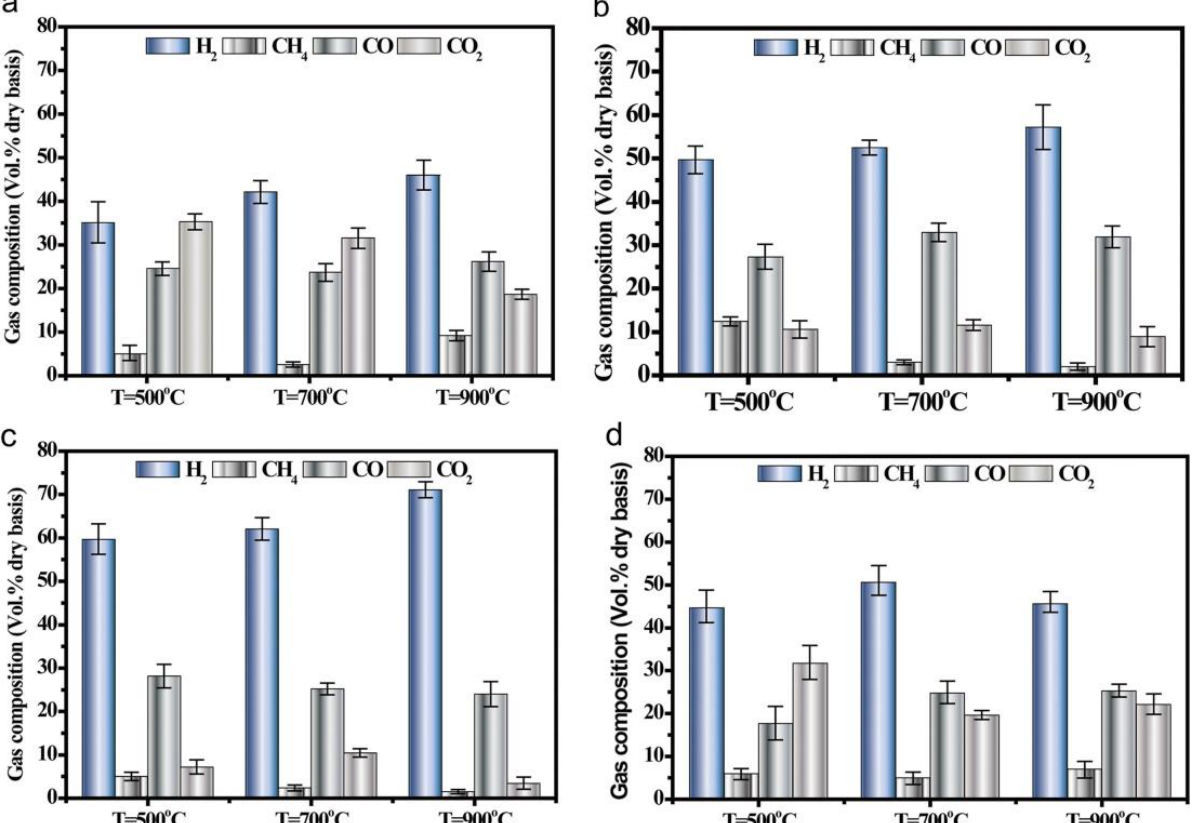
Figure 8. The gas product selectivity from the catalytic gasification of sewage sludge using catalysts from ( a ) hydrochar and ( b - d ) nickel@hydrochar with different concentrations of nickel (0.1, 0.5, and 1.0) at different gasification temperatures from 500 to 900 °C. Reproduced from [74]. Copyright (2019), with permission from Elsevier.